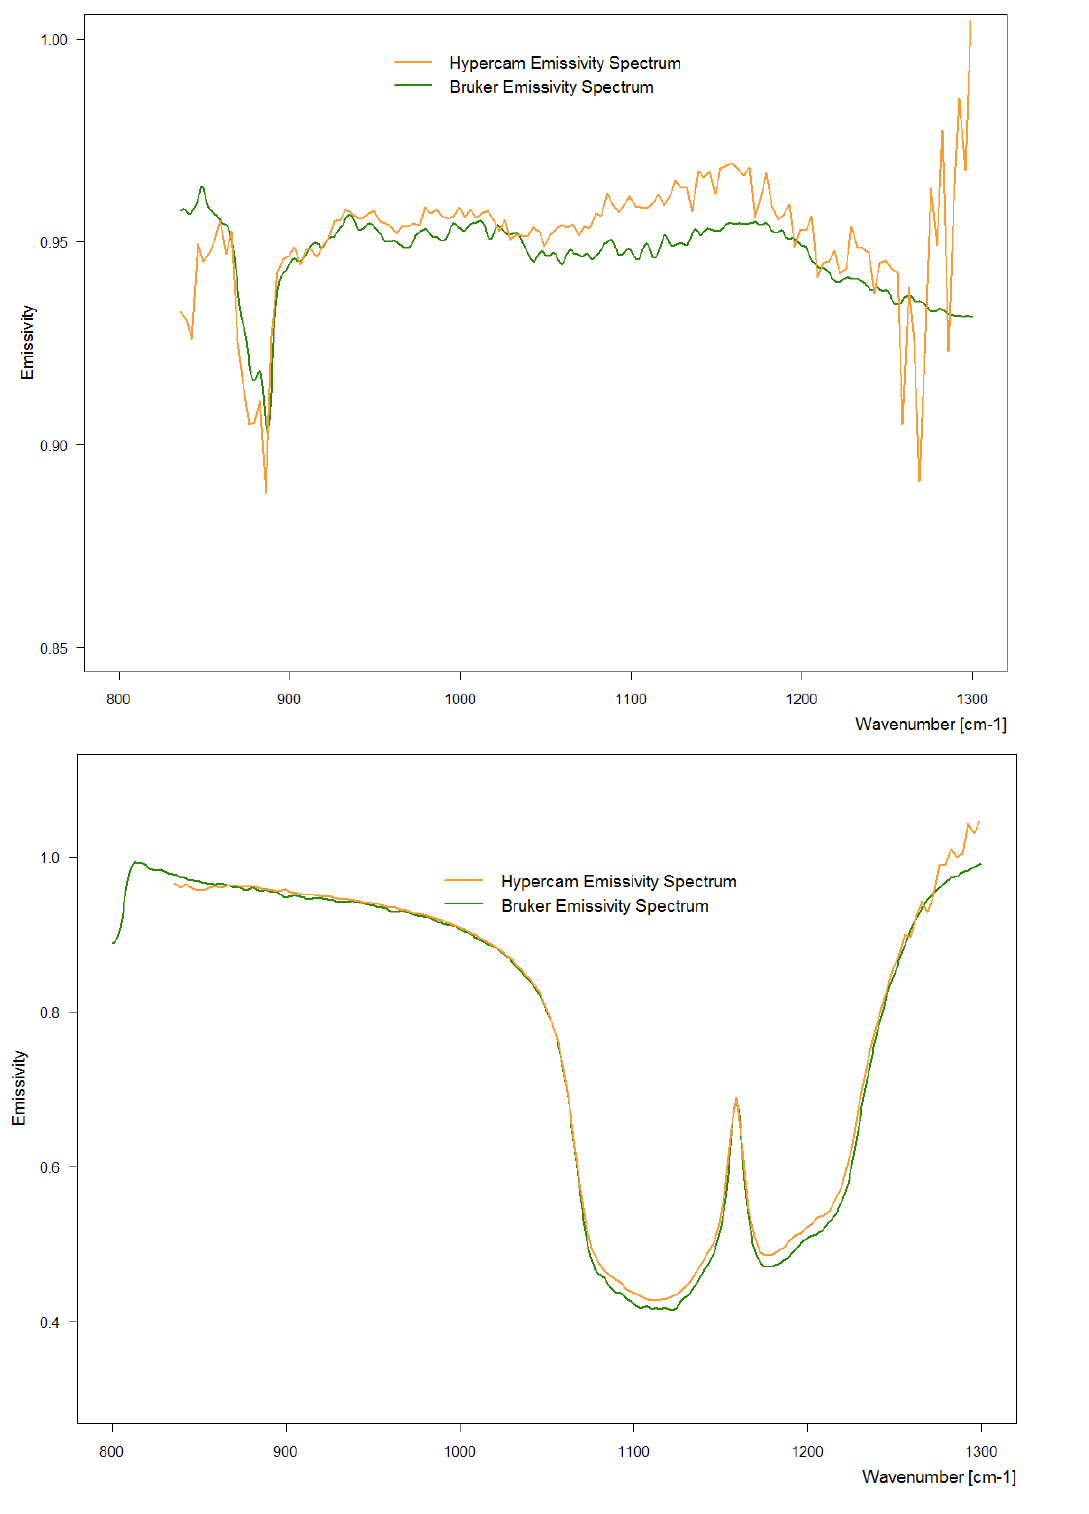
Figure 6. Emissivity spectra of Calcite ( top ), and Quartz ( bottom ) derived from Hyper-Cam and Bruker